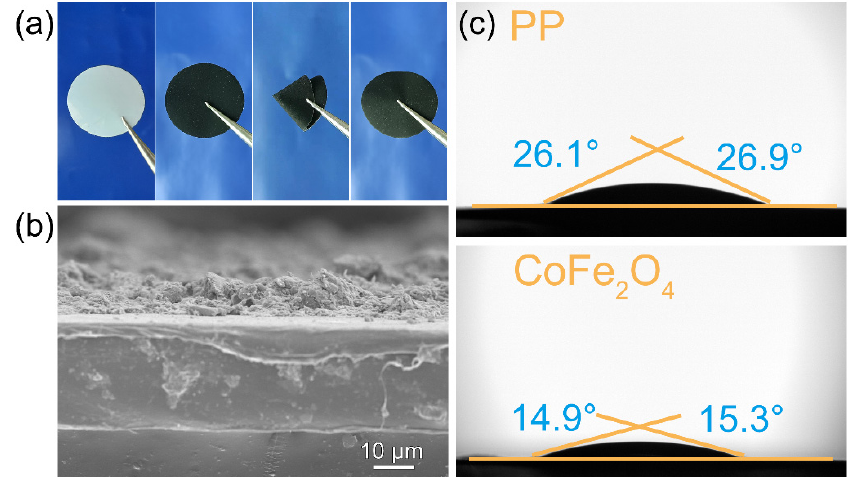
Figure 3. ( a ) Optical photographs of the folding and unfolding experiments of CoFe 2 O 4 -Celgard and pure Celgard separators; ( b ) cross-sectional SEM of CoFe 2 O 4 improved separator; ( c ) the contact angle with electrolyte of different separators.